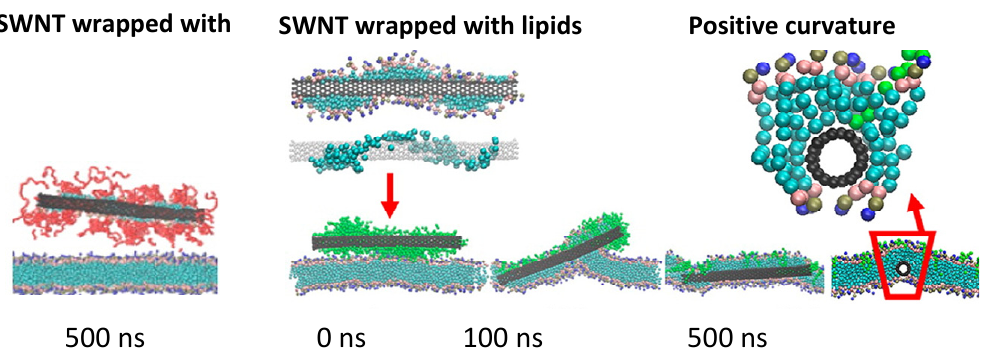
Figure 10. Snapshots of simulations of the lipid bilayer and the SWNT wrapped with PEGylated and unPEGylated lipids (respectively, left and right). The cross section of SWNT shows positive curvature in the lipid bilayer (upper right). (Reprinted with permission from [170]. Copyright 2013 American Chemical